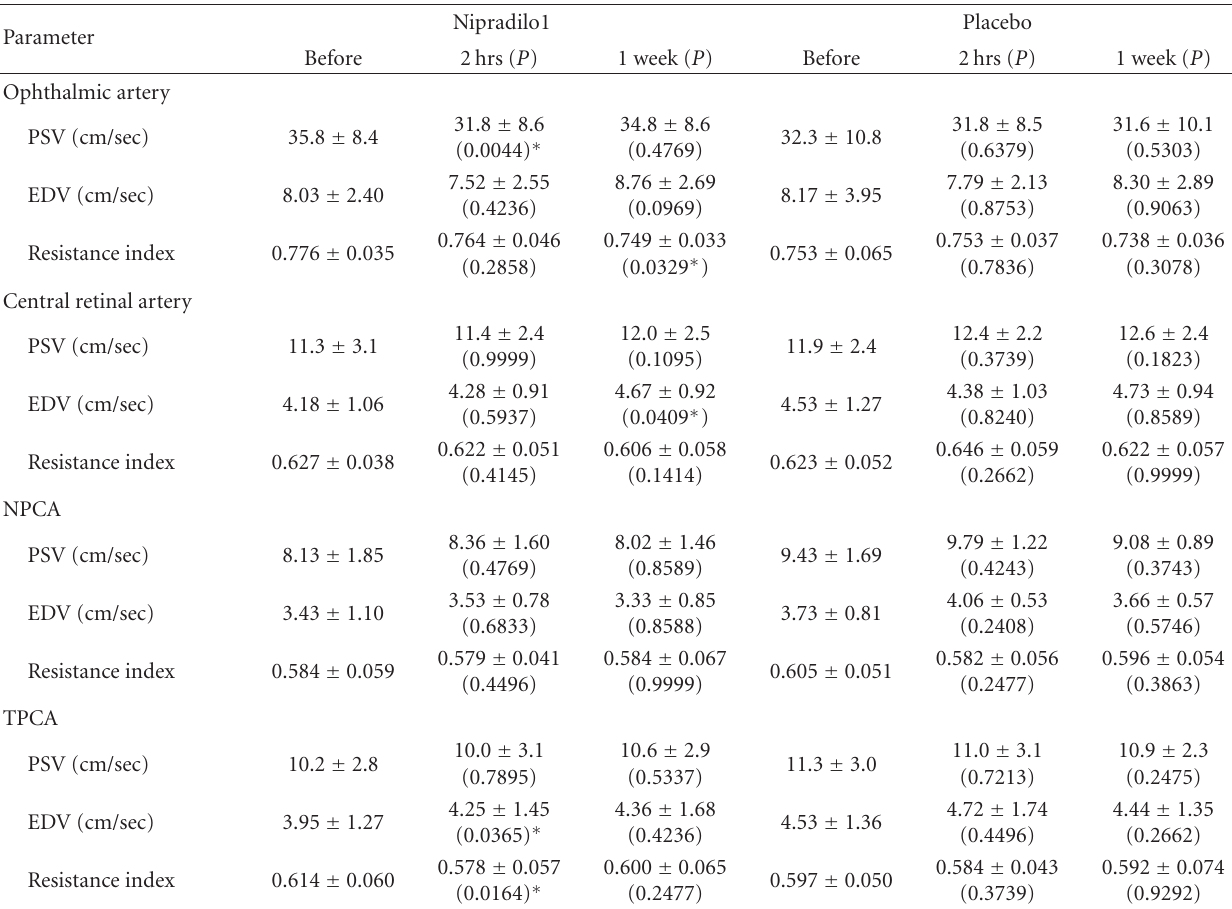
Table 2: Results of color Doppler imaging in normal